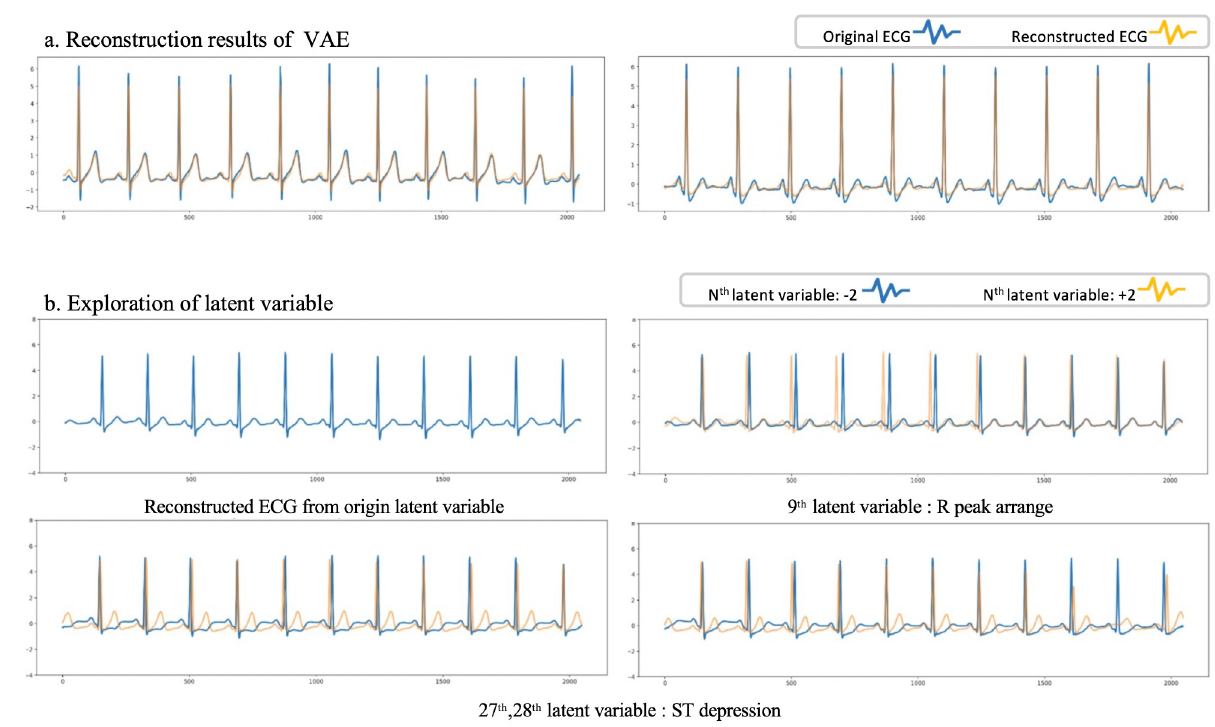
Fig 4. Reconstruction output and feature space exploration. (a) Examples of the reconstruction output of a normal electrocardiogram (ECG) are shown. Original ECG data (blue) and reconstructed ECG data (yellow) are not significantly different. (b) Examples of latent space exploration. A single blue line represents the reconstruction output of the sampled origin feature vector in the first ECG. In the remaining three ECGs, the blue line represents the reconstruction output of the feature vector that subtracts 2 from the Nth feature variable. The yellow lines represent the reconstruction output of the feature vector that adds 2 to the Nth feature variable.